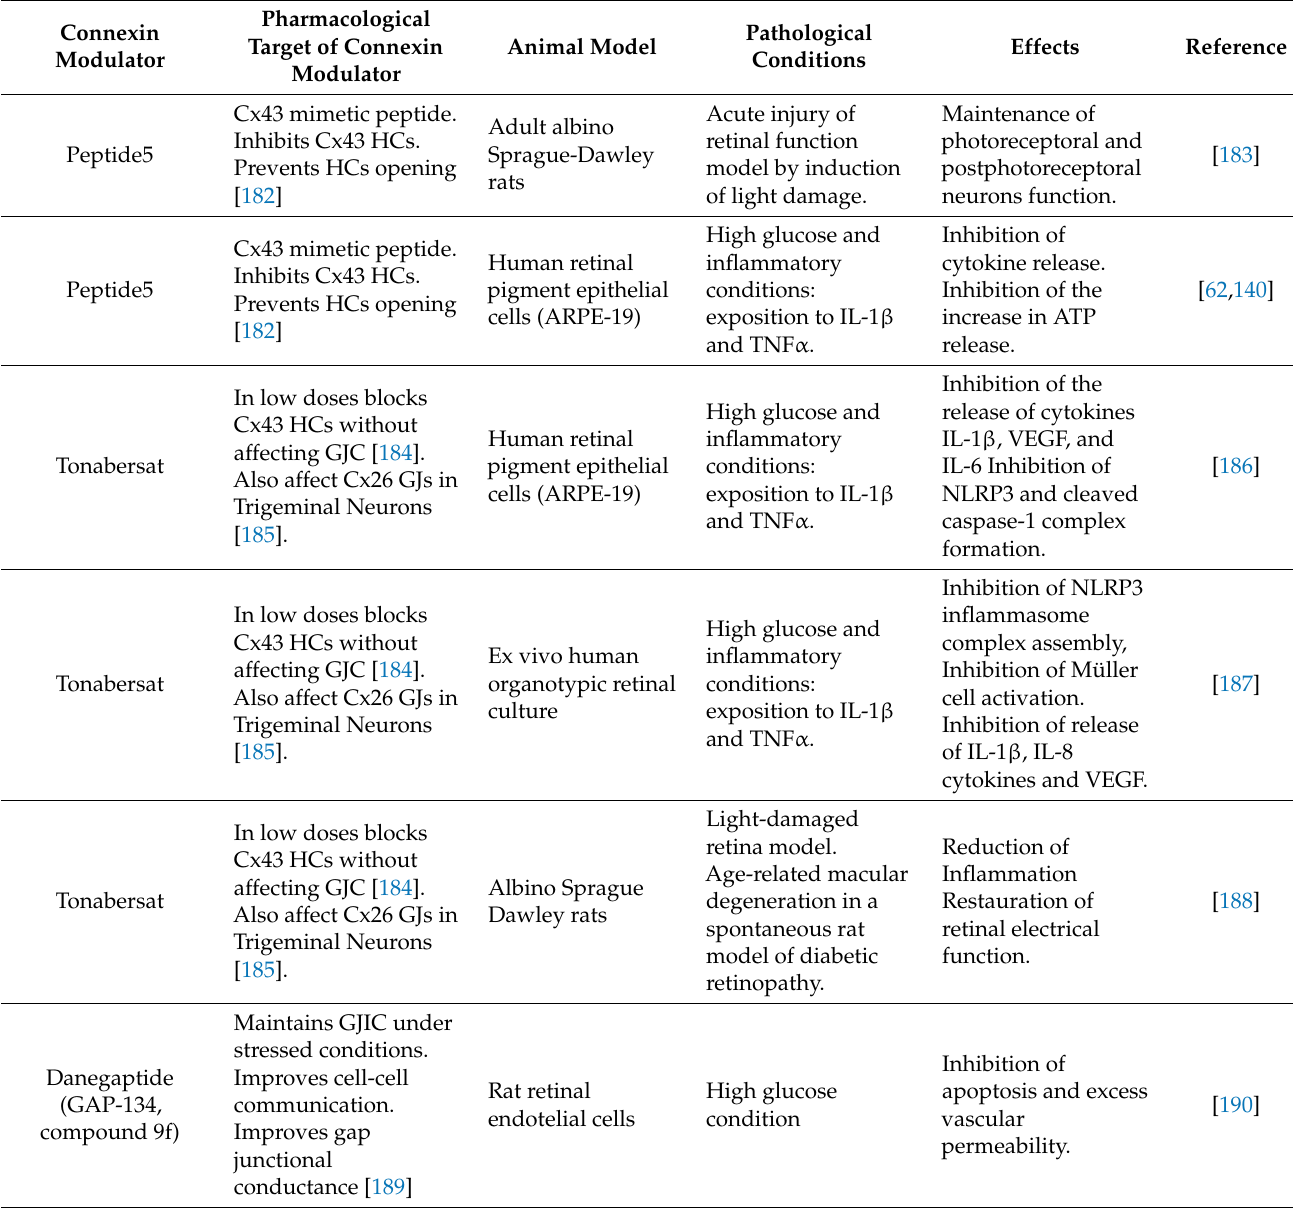
Table 2. Summary of Connexin modulator treatment strategies for diabetic